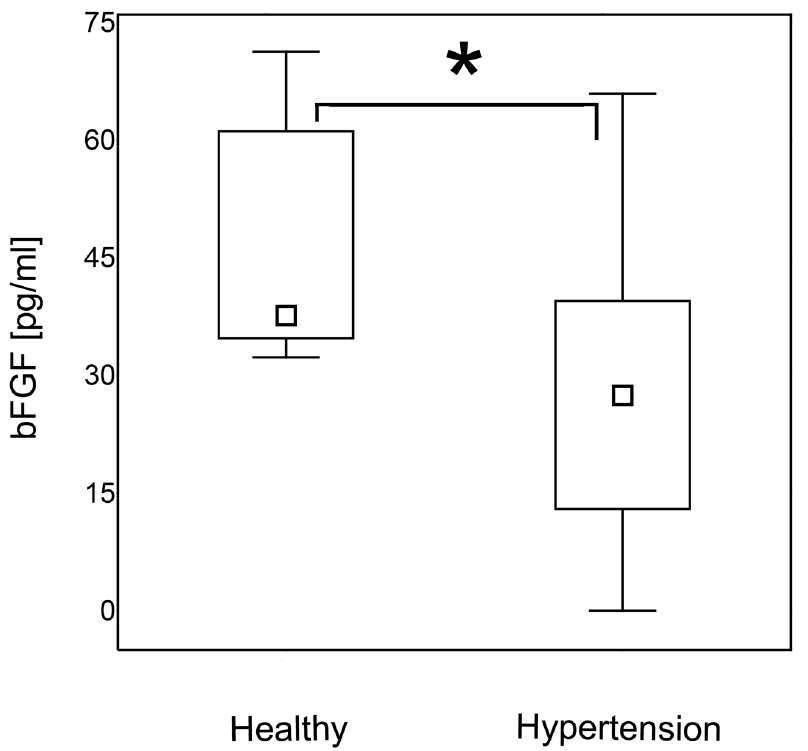
Fig 6. bFGF concentration in hypertension. Patients with hypertension were characterized by lower serum concentration of bFGF than healthy individuals (Mann- Whitney U test; p = 0.01). The data are presented as medians (symbols inside the boxes), 25 – 75% percentiles (boundaries of the boxes) and minimum — maximum (error bars outside the boxes). Statistical significance (p < 0.05) is marked with “ * ” .